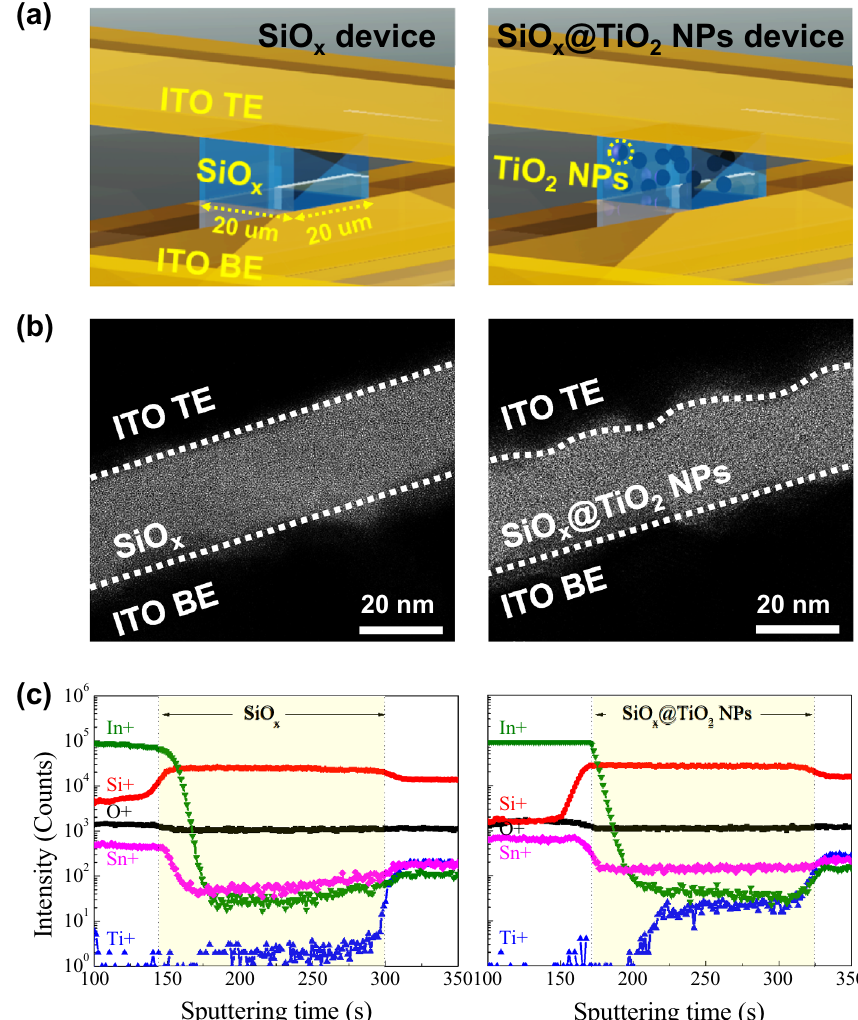
Figure 1. ( a ) Schematic structures of the cross-bar array architecture, ( b ) the cross-sectional TEM images, and ( c ) depth-profiling with ToF–SIMS of the SiO x and SiO x @TiO 2 NPs resistive switching